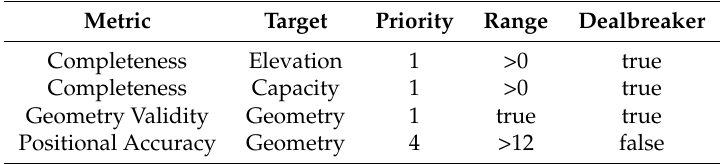
Table 8. Rescue Point Requirement Profile: A rescue point’s quality is well-defined if the geometry is valid, the rescue point may be found with an accuracy of greater than 12 decimal places, its capacity is annotated and its elevation is